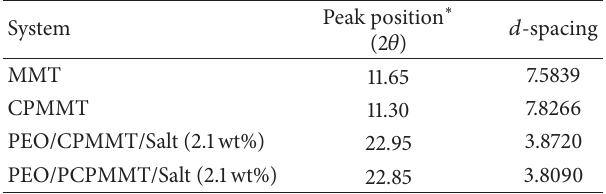
Table 1: Values of 𝑑 -spacing for various systems